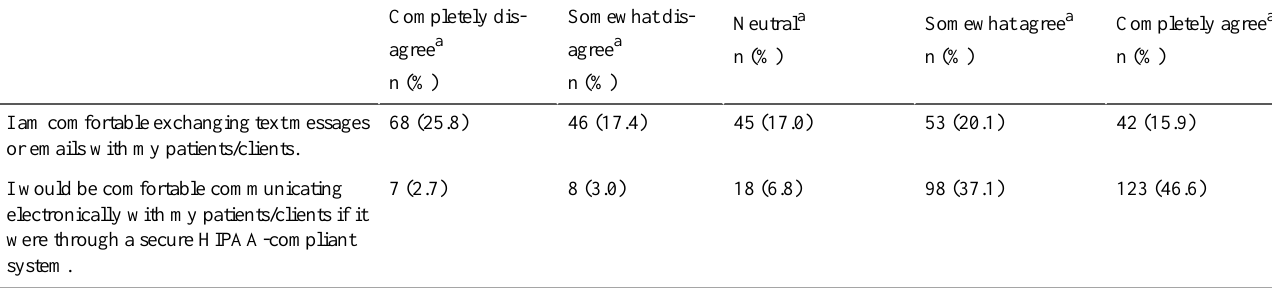
Table 2. Provider comfort using cessation apps and electronic client/patient communication